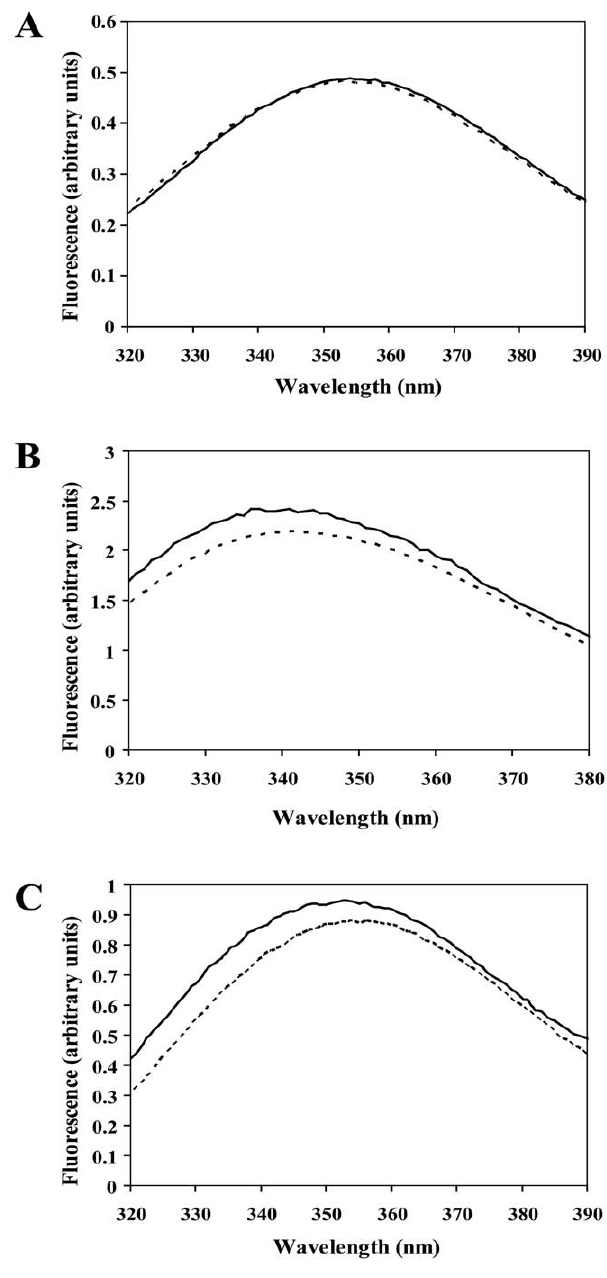
Figure 3. HrpB2 XAC induced changes in HrcU XAC fluorescence. Fluorescence emission spectra of HrcU XAC_207-264 (A), HrcU XAC_207-357AAAH (B) and HrcU XAC_His277-357 (C) in the absence (dotted lines) and presence (solid lines) of HrpB2. All proteins (2 m M) were dissolved in 5 mM sodium acetate (pH 6.0). Spectra were recorded at 25 u C using an excitation wavelength of 280 nm. doi:10.1371/journal.pone.0017614.g003 HrpB2 XAC variants (Table 1) in the D hrpB2 strain. To test the importance of the FQALM motif we mutated these residues to LQGPR and expressed the mutant protein (HrpB2 XAC_LQGPR ) in the D hrpB2 strain using the pUFR047 _hrpB2 LQGPR plasmid. The D hrpB2 + pUFR047 _hrpB2 LQGPR strain was able to cause citrus canker symptoms in a manner indistinguishable from the wild- type Xac strain (Fig. 4B). Therefore, the FQALM motif does not